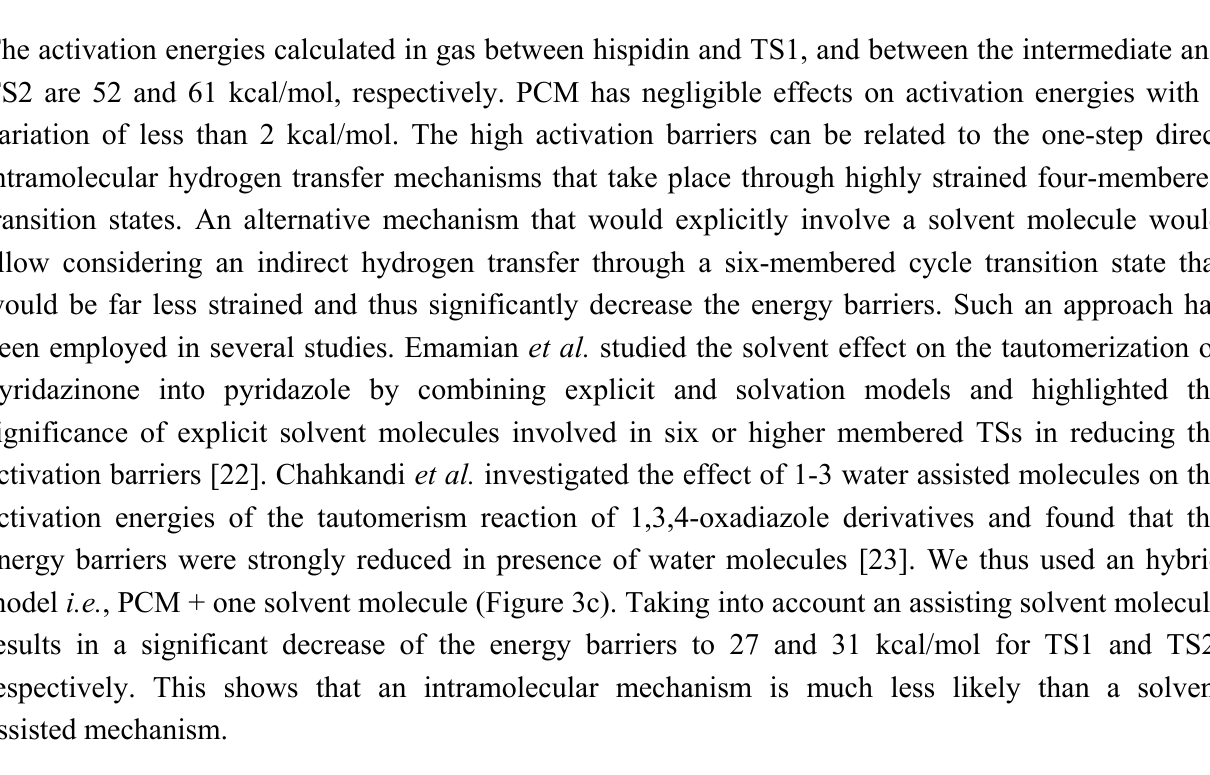
Figure 2. Electronic spin density distribution of i-O • hispidinyl and isohispidinyl radicals ( a ) 4-O • , 11-O • and 12-O • hispidinyl radicals; ( b ) 2-O • , 11-O • and 12-O • isohispidinyl